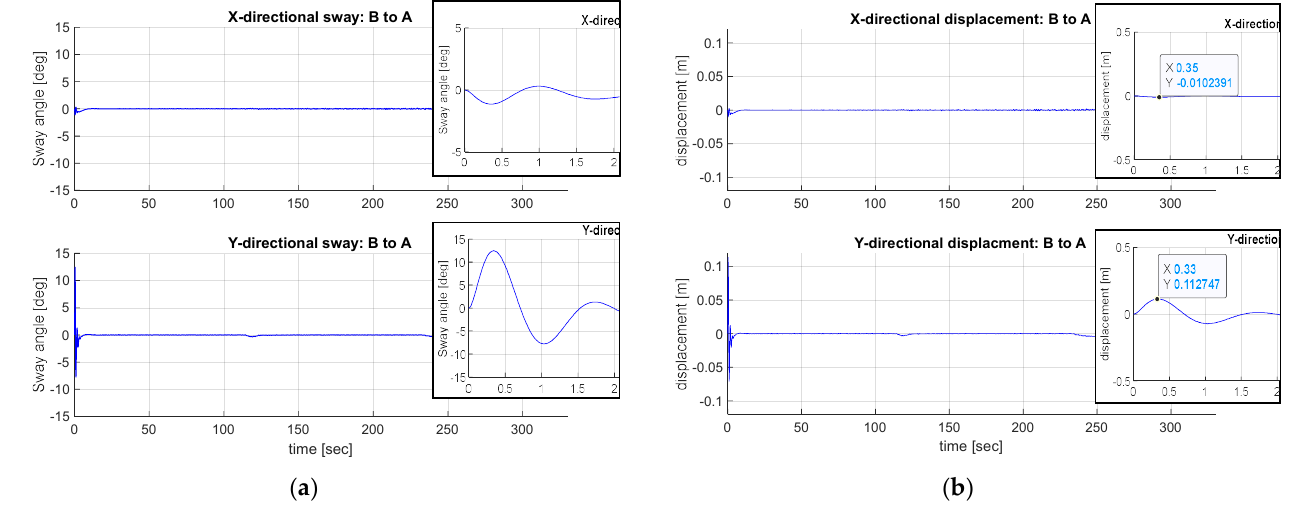
Figure 20. Motion control performance. ( a ) Sway angle reduction in x/y direction. ( b ) Displacement of the patient in x/y direction.